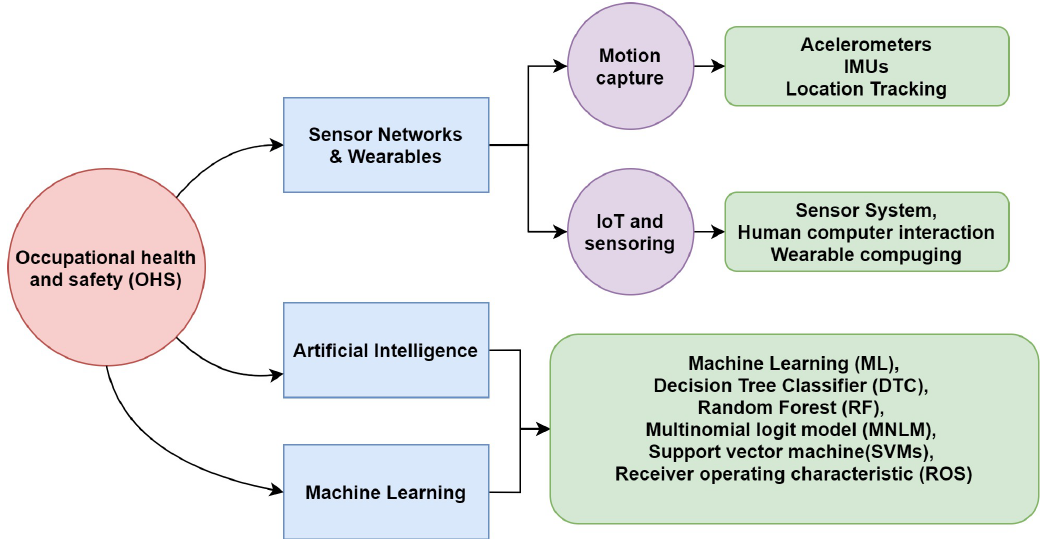
Figure 1. A block diagram of the devices.